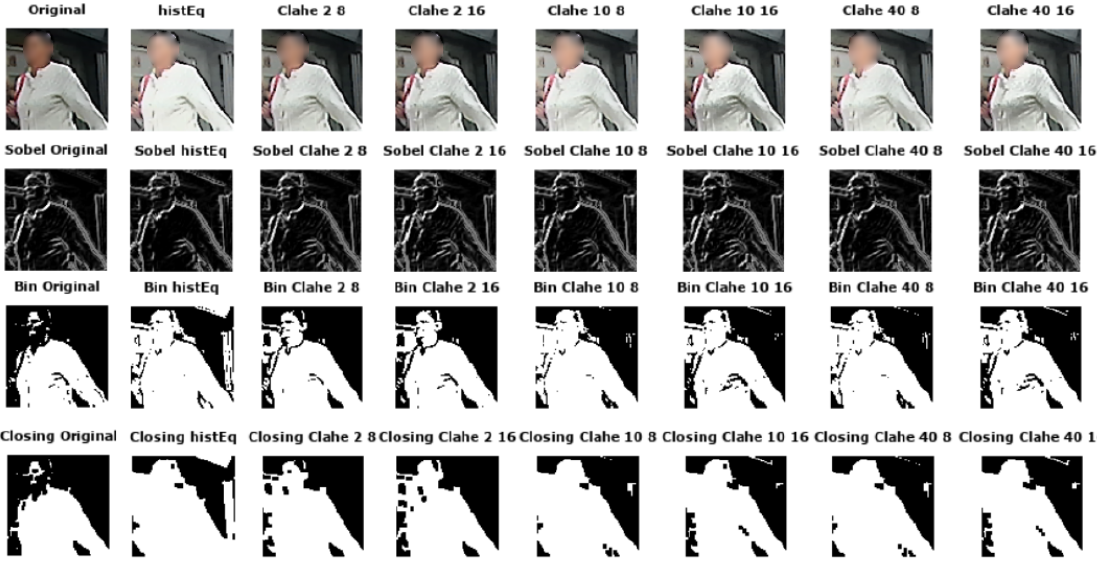
Figure 14. Samples of contrast enhanced images with various